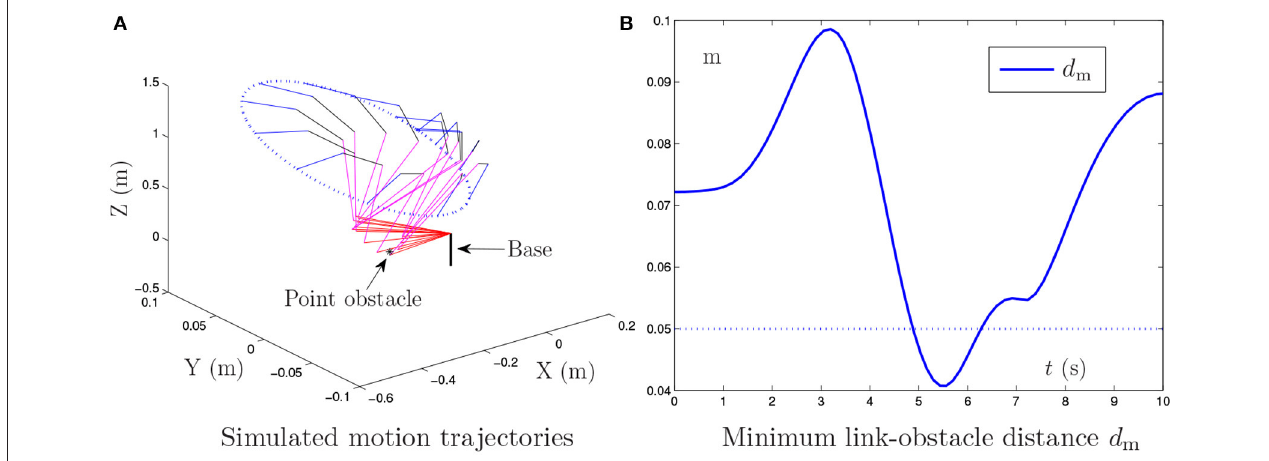
FIGURE 2 | Simulation results synthesized by the obstacle avoidance method in Lee and Buss (2007) for the PA10 end-effector tracking the circular path, where the zero noise is considered.